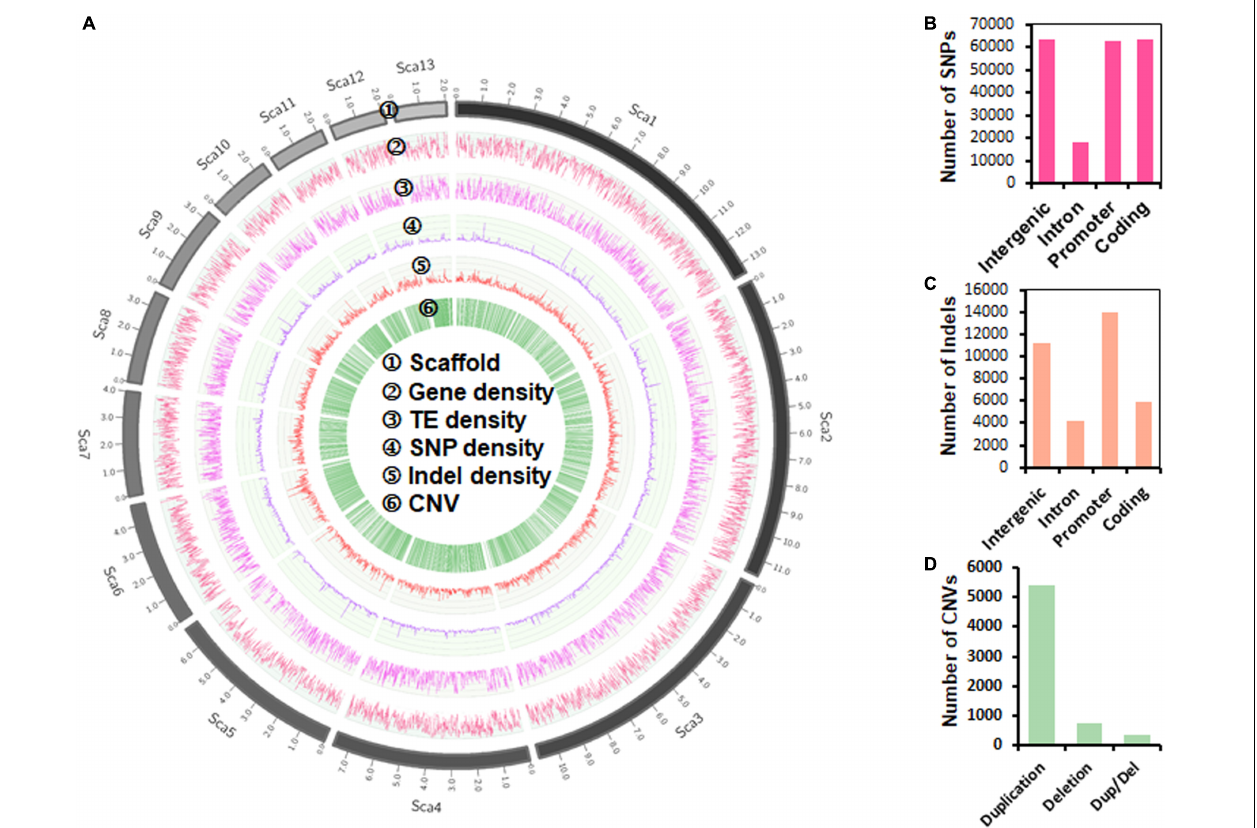
FIGURE 1 | Genome-wide landscape of genetic variation in P. sojae. (A) Circos plot of the top 13 longest scaffolds (90.25% coverage of the P. sojae genome). Tracks from outside to inside are: (cid:192) scaffolds (Sca) number; (cid:193) – (cid:196) density of gene, transposable element, SNP (single-nucleotide polymorphism) and Indel (insertion or deletion) in non-overlapping 10 kb windows; (cid:197) CNV (copy number variation) location. (B) Distribution of SNPs in different gene regions. (C) Distribution of Indels in different gene regions. (D) Categories of